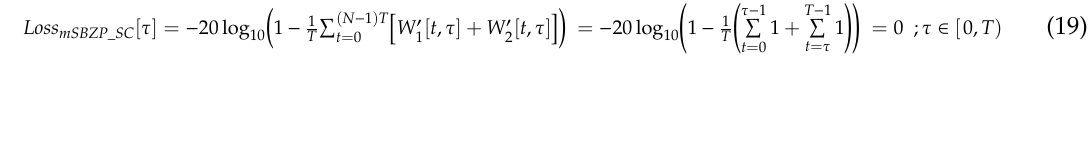
Figure 17. The mSBZP for SC algorithm, W ' 1 and W ' 2 -functions .